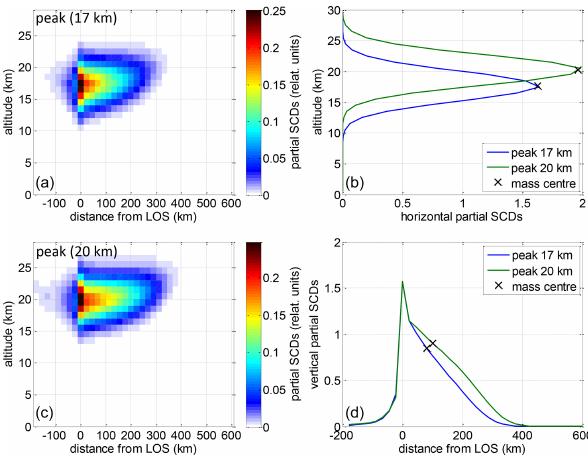
Figure A2. (a, c) Simulated partial SCDs (products of the box AMFs and the local OClO number density values) calculated for the profile with the peak at 17km (a) and 20km (c) . (b, d) Hor- izontally (b) and vertically (d) integrated partial SCDs with mass centres